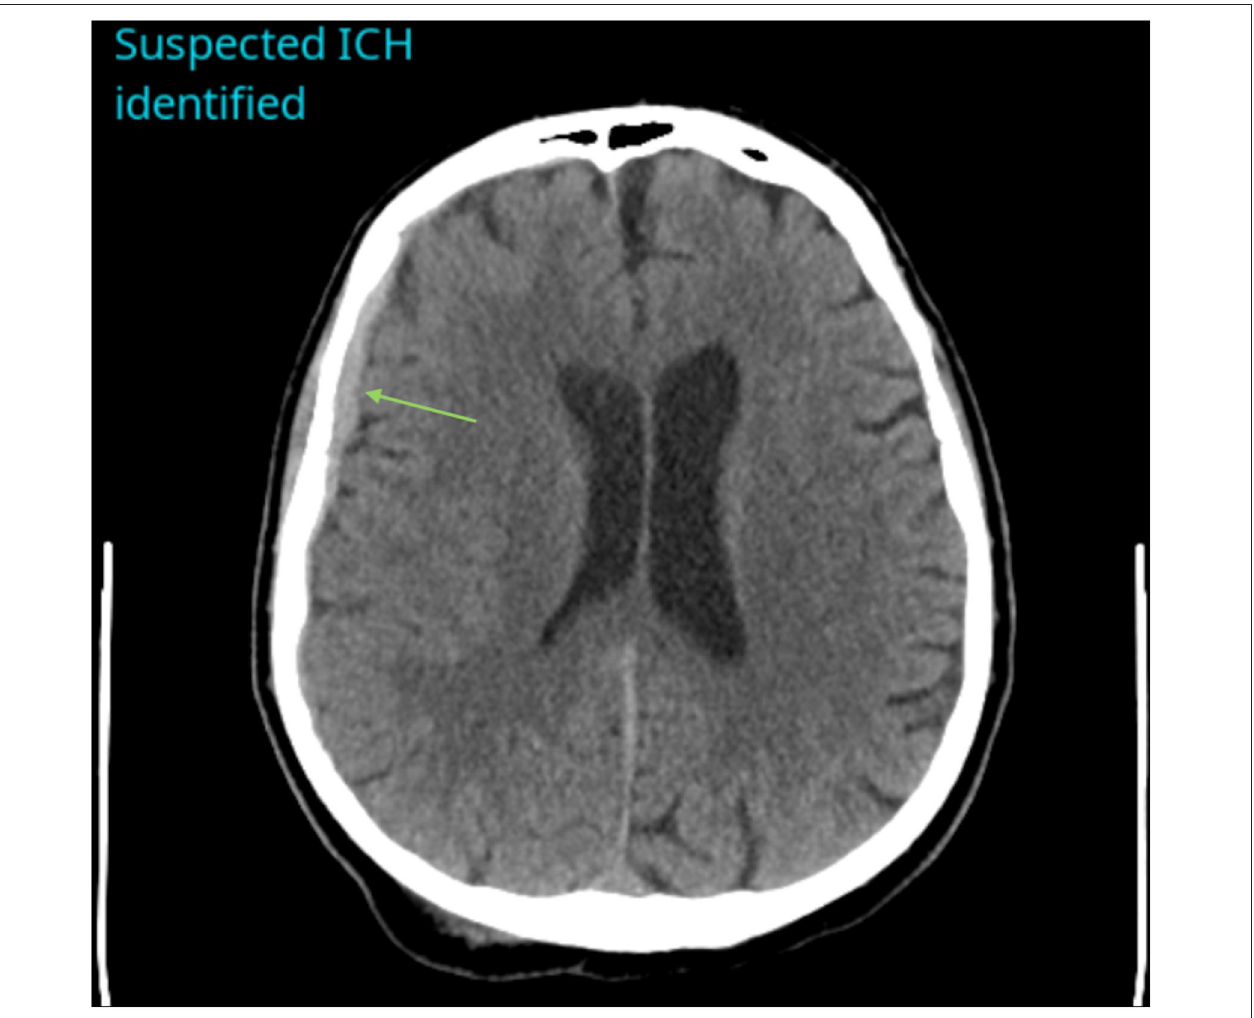
FIGURE 1 | Example of a positive ICH identified by CINA ® . There is an acute subdural hemorrhage along the right cerebral convexity on non-contrast CT (green arrow).